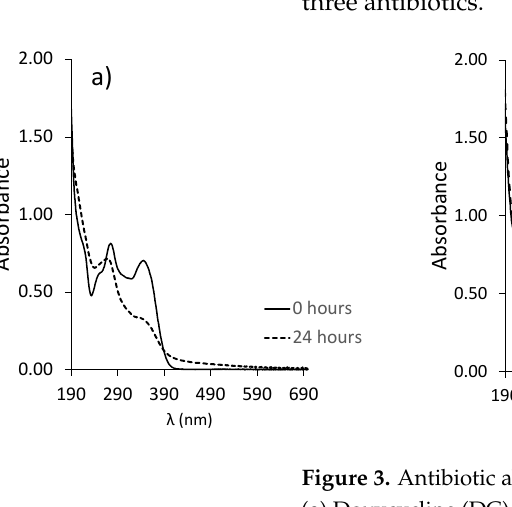
Figure 2. Antibiotic absorption spectra and speciation at different pHs (4.0, 5.5, and 7.2). ( a ) Doxycy- cline (DC) spectrum and DC speciation; ( b ) Enrofloxacin (ENR) spectrum and ENR speciation; ( c ) Sulfamethoxypyridazine (SMP) spectrum and SMP speciation.